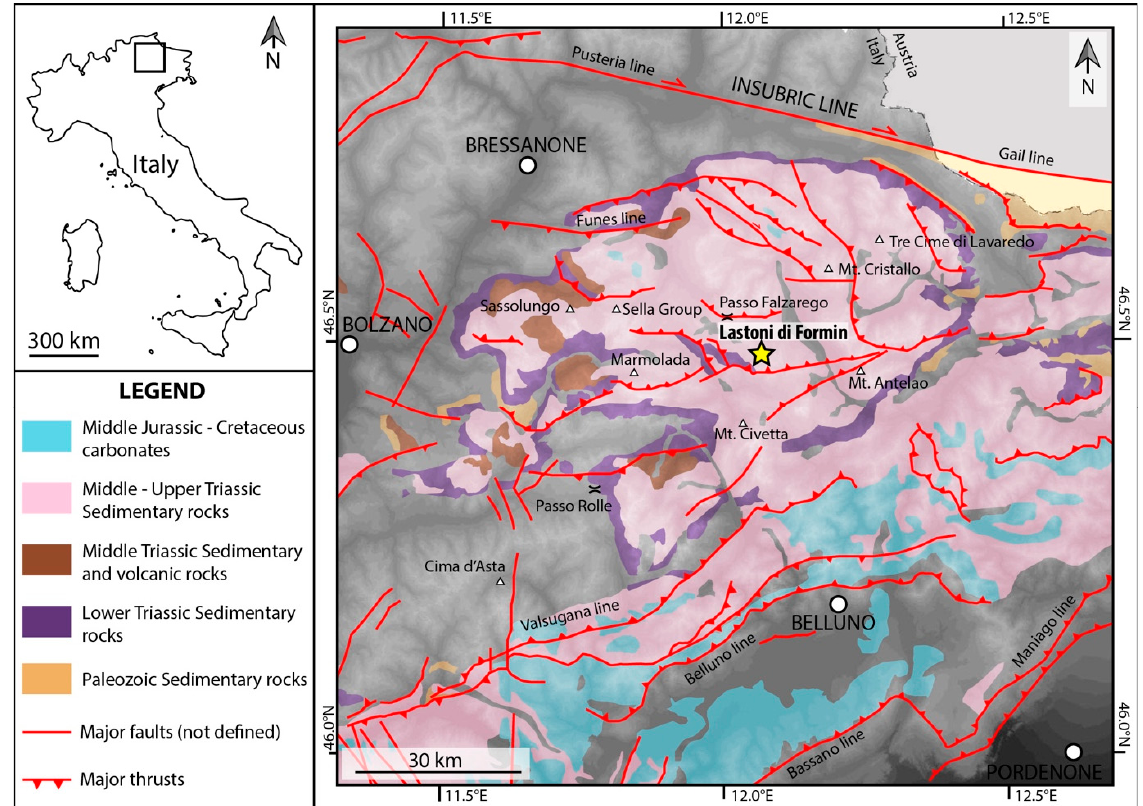
Figure 1. Simplified geological map of the central Dolomites region showing the major structural lineaments and the main sedimentary rocks from Paleozoic to Cretaceous (stratigraphy modified from [19,20]). The major structural lineaments were digitalized following the structural model at a scale of 1:500,000 from [21,22] and the geological map of Italy at a scale of 1:1,000,000 from [20] and integrating with the geological map at a scale of 1:50,000 from [23–27]. The background greyscale represents the Digital Elevation Model (DEM) of Italy (retrievable from [28]); lighter colors represent higher elevations.